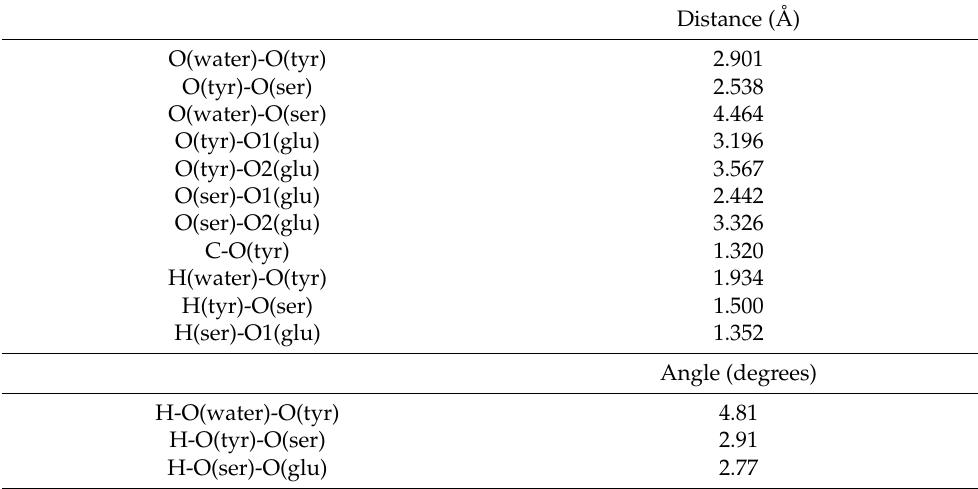
Table 3. Structural parameters (distance (Å) and angle (degrees)) of psamFP488 in the neutral form optimized in the Network1 arrangement.